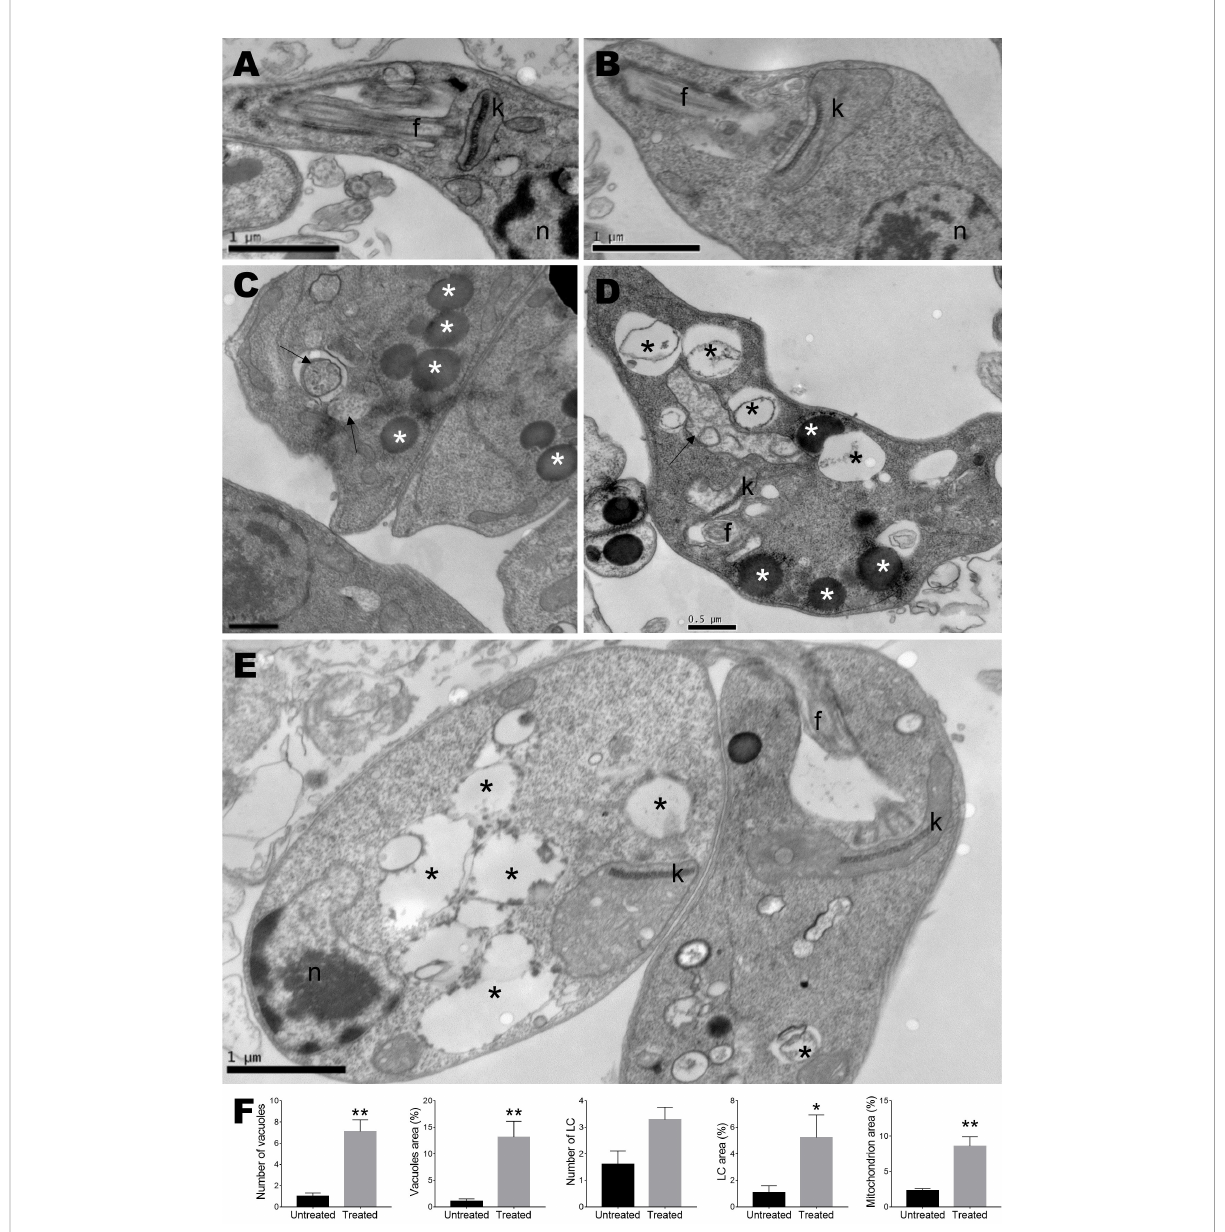
FIGURE 4 Ultrastructural analysis of Leishmania amazonensis promastigote forms. (A) Untreated parasites. (B – E) Parasites treated with monomethylsulochrin (18.04 m M) for 24 h. (F) Statistical differences data in the quanti fi cation of the vacuoles, lipid corpuscles, and mitochondria damage between the cells in the untreated group and the groups treated with monomethylsulochrin are shown. Images show several vacuoles dispersed in the cytoplasm (black asterisks), lipid corpuscles (white asterisks), vesicles with electron-dense material inside (arrows), and changes at the mitochondria outer membrane and abnormal disposition around the kinetoplast. f: fl agellum; k: kinetoplast; n: nucleus; LC: lipid corpuscles. Images are representative of two independent experiments from fi ve untreated and at least 10 treated cells. Data are presented as mean ± SD , and the difference between treated and untreated group was evaluated by Mann – Whitney test with * p > 0.05 and ** p >